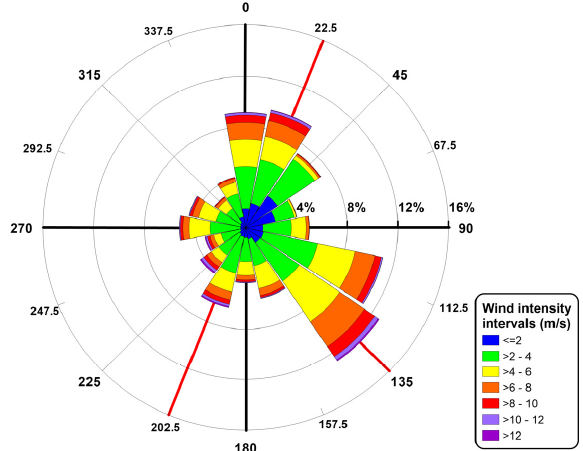
Figure 2. Wind rose obtained by data collected from the C-CEMS weather station between 2008 and 2017.